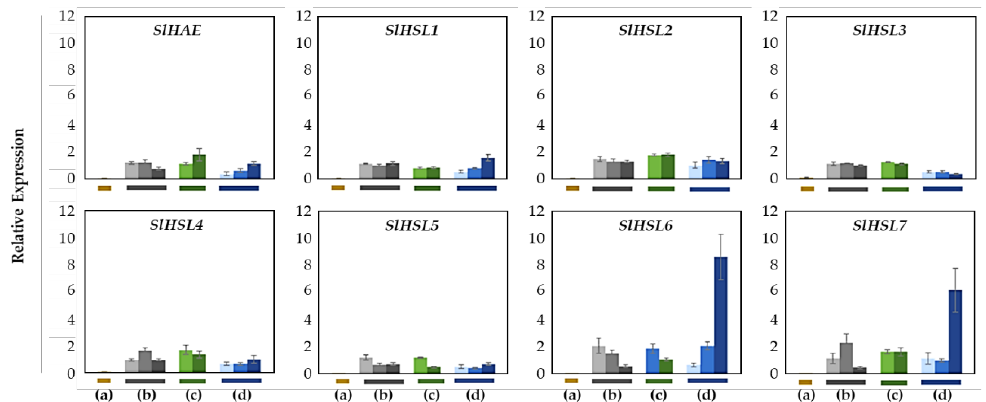
Figure 6. Relative gene expression patterns of SlHAE for the AZ/NAZ in four tomato variants. (a) jointless (j), (b) functionally impaired jointless (fij), (c) functionally impaired jointless like (fij like), and (d) normal joint (NJ). Except for the j (collected from only the midpoint), samples of AZ and NAZ (proximal side of pedicel) from several flower developmental stages available on the peduncle of the variant that covers a relatively broad range of flower abscission development were collected (Figure S1). One developmental stage of j, three developmental stages of fij, two developmental stages of fij like, and three developmental stages of NJ were collected. The samples from two neighboring peduncles on the primary inflorescence were utilized and combined for the respective developmental stages of AZ and NAZ samples from each peduncle to enrich the samples for RNA extraction. Each bar graph (AZ/NAZ), except for the j, of the natural abscission variant, represents the result from those several flower abscission developmental stages. The means ± SD of three independent replicates were used to present data sets.